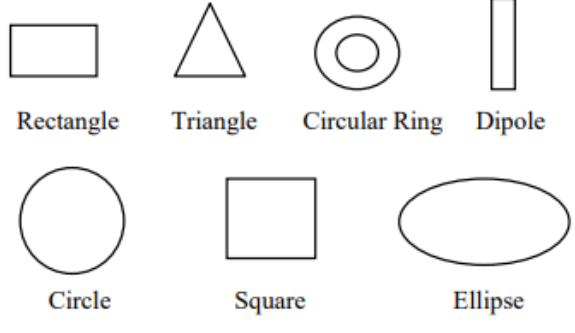
Figure 1. Different types of microstrip patch antennas